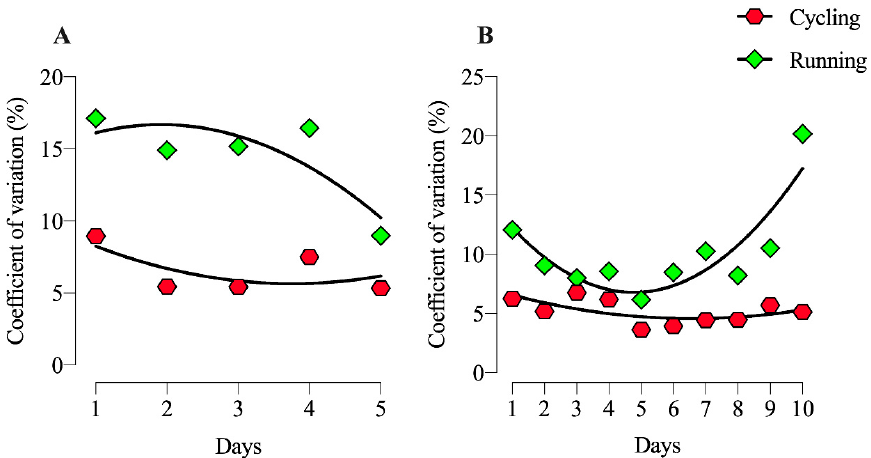
Figure 4. Pacing variation (coefficient of variation; CV) in each of the race days in a Quintuple ( A ) and Deca ( B ) Iron ultra ‐ triathlon in the cycling and running.